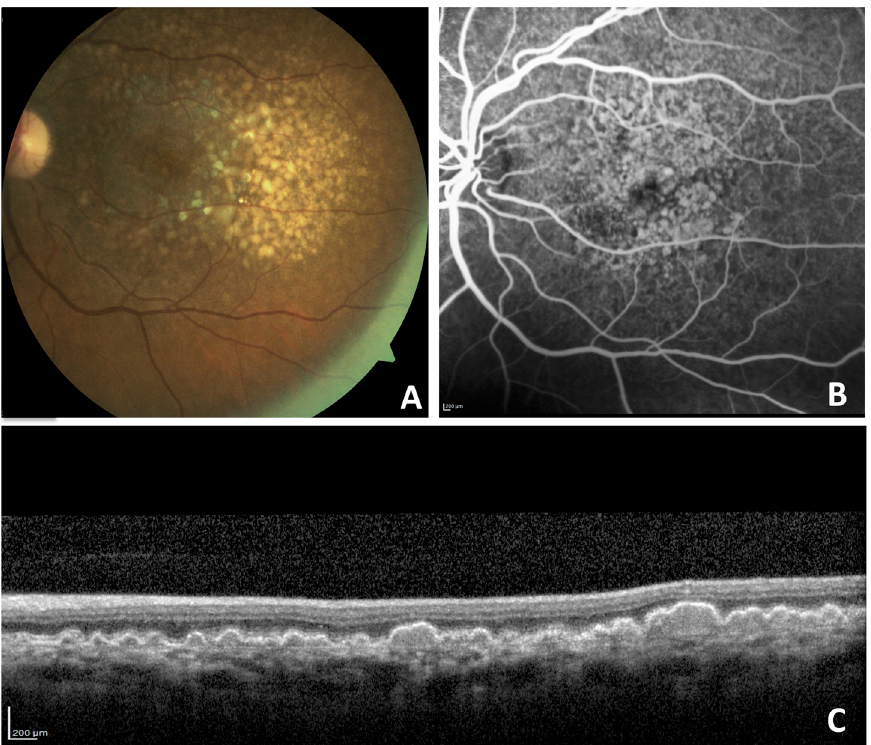
Figure 1. A 59-year-old woman with non-neovascular age-related macular degeneration with large confluent drusen on color fundus photograph ( A ), late-phase fluorescein angiography ( B ), and optical coherence tomography ( C ).